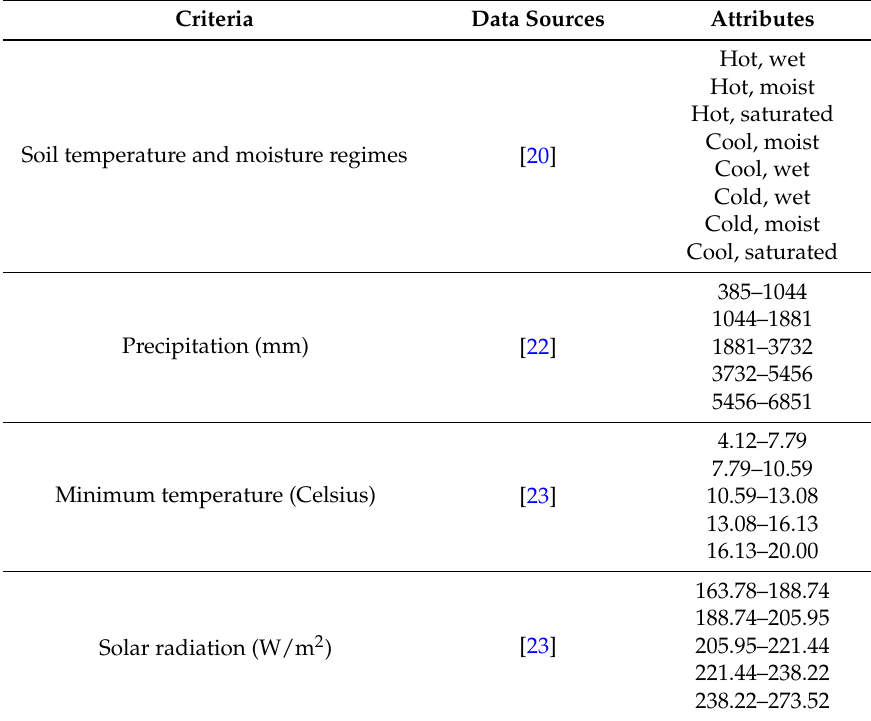
Table 1. Critical factors affecting banagrass